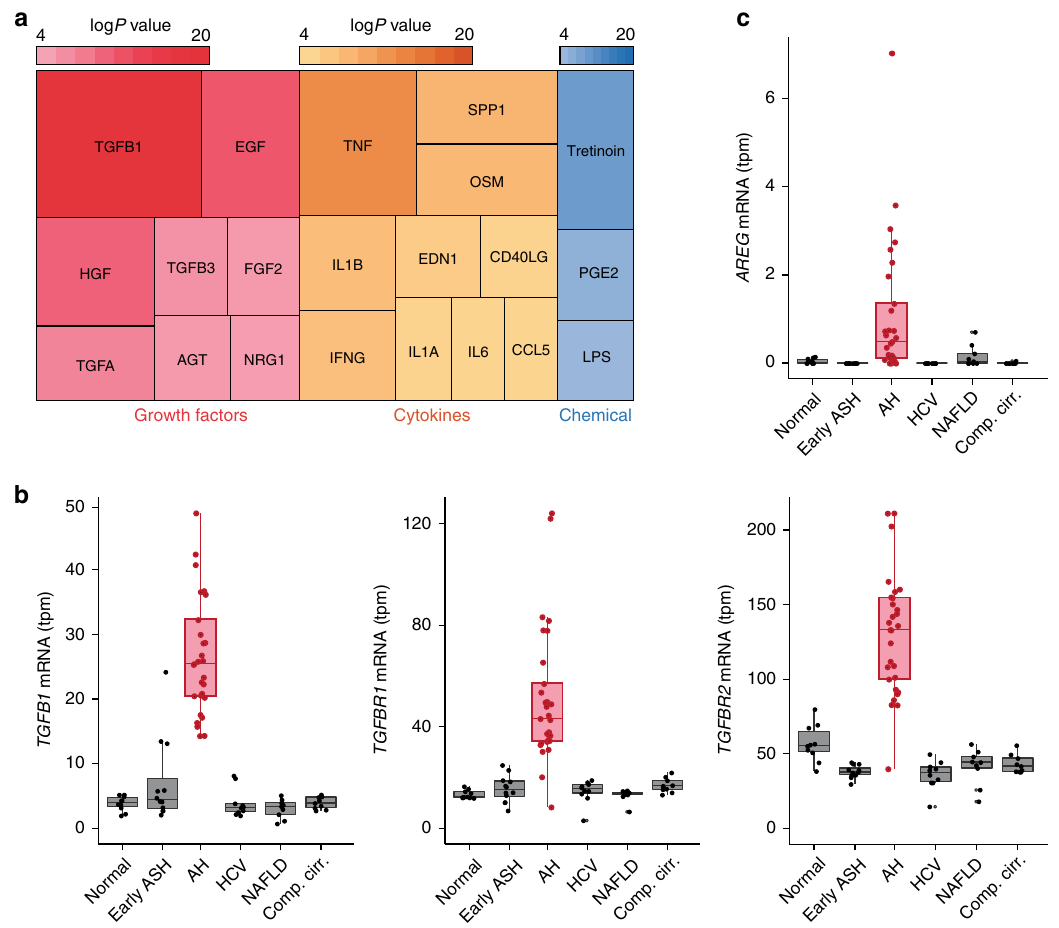
Fig. 4 TGF β 1 is the main upstream regulator of transcriptomic reprogramming in ALD. a Treemap of the top predicted activated growth factors, cytokines and chemicals as detected by IPA. Color and box areas are related to p -values, indicated in top-right color-scale. Most signi fi cant hits ( P < 10 − 4 ) are shown. b , c mRNA abundance in transcripts per million (tpm) from normal livers, AH livers and livers of non-alcohol-related chronic disease of b TGF β 1, TGF β RI, and TGF β RII and c Amphiregulin (AREG). For box-and-whisker plots: perimeters, 25th – 75th percentile; midline, median; whiskers, minimum to maximum values; individual data points are represented. Gene expression levels are presented in transcripts per million reads